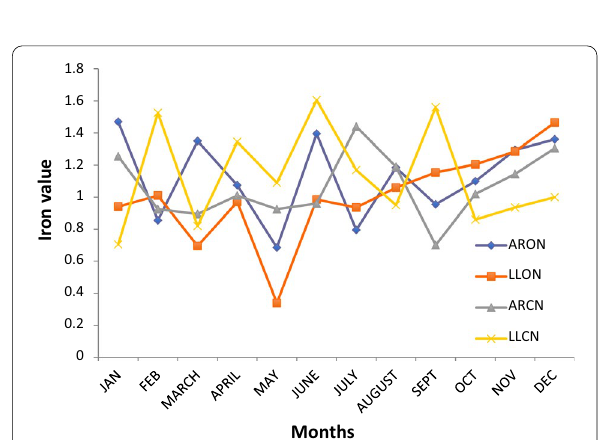
Fig. 4 Mean Comparative Iron (Fe) concentration among C. nigrodigitatus and O. niloticus species collected from Asejire Reservoir and Lagos Lagoon